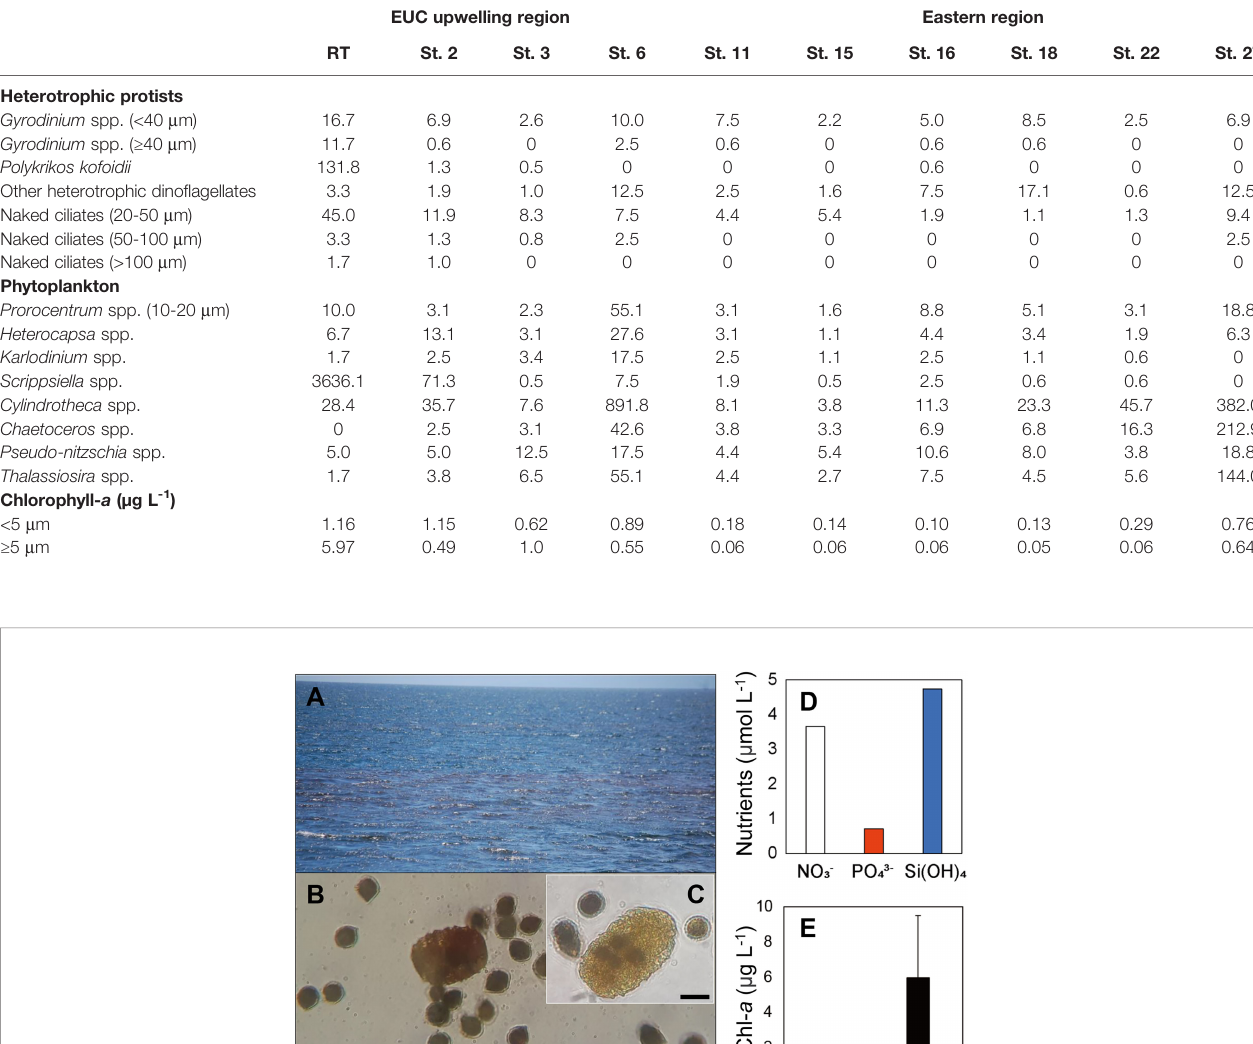
TABLE 2 | Cell abundances (cells mL -1 ) of dominant phytoplankton taxa (>10 m m in cell length of dino fl agellates and diatoms) and heterotrophic protists during the survey period in 2018. EUC upwelling region Eastern